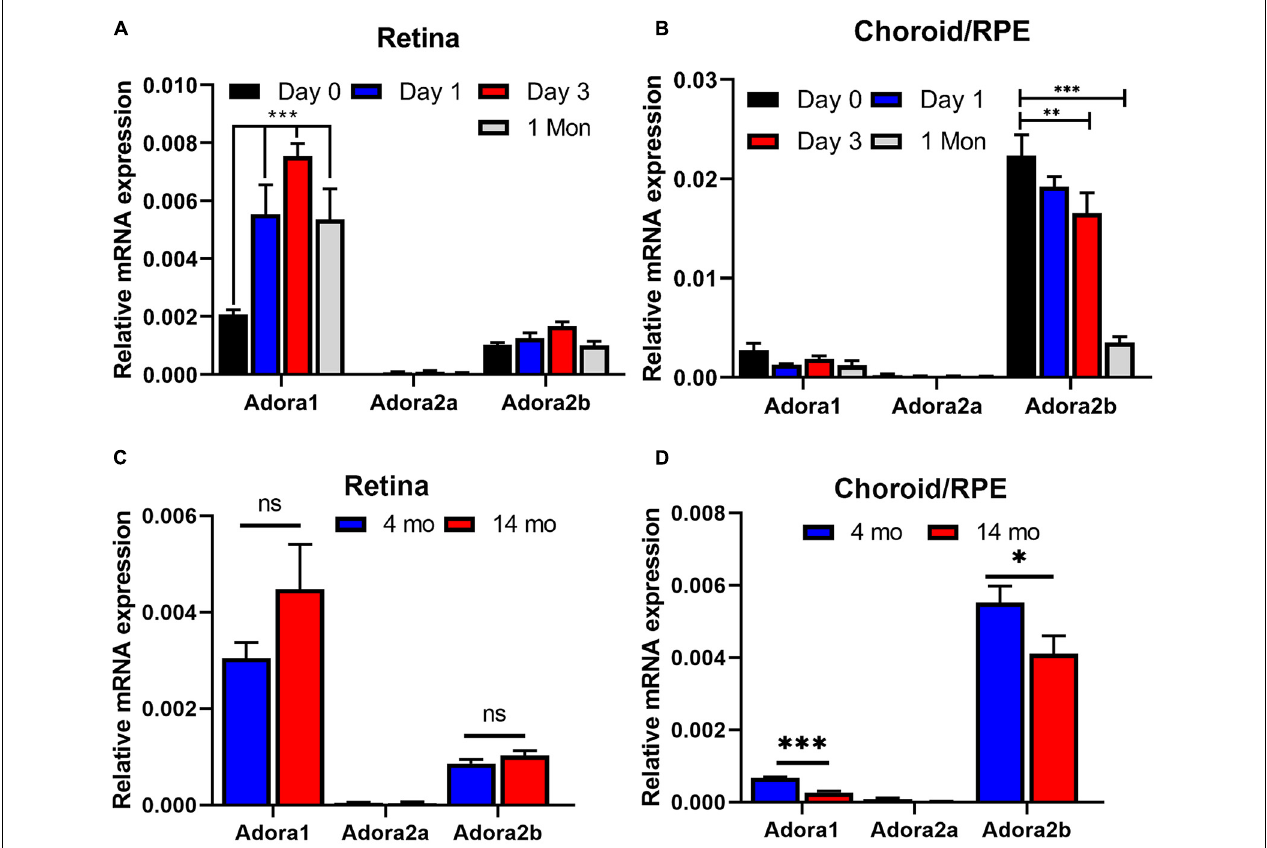
FIGURE 10 | The impact of laser treatment and age on expression of adenosine receptors in retina and choroid. RNA was prepared from retina (A,C) and choroid/RPE (B,D) of mice [2-month-old (A,B) , 4-month- and 14-month-old (C,D) ; C57BL/6j male and female] without laser or 1 day, 3 days, and 1 month post laser. Please note significant up regulation of A 1 with laser treatment in the retina, while A 2 B was decreased in the choroid. Aging minimally affected adenosine receptor (AR) expression in the retina (C) . However, the expression of A 1 and A 2 B was significantly decreased with age in choroid RPE (D) . (* p < 0.05, ** p < 0.01, *** p < 0.001; n = 5 mice/group).